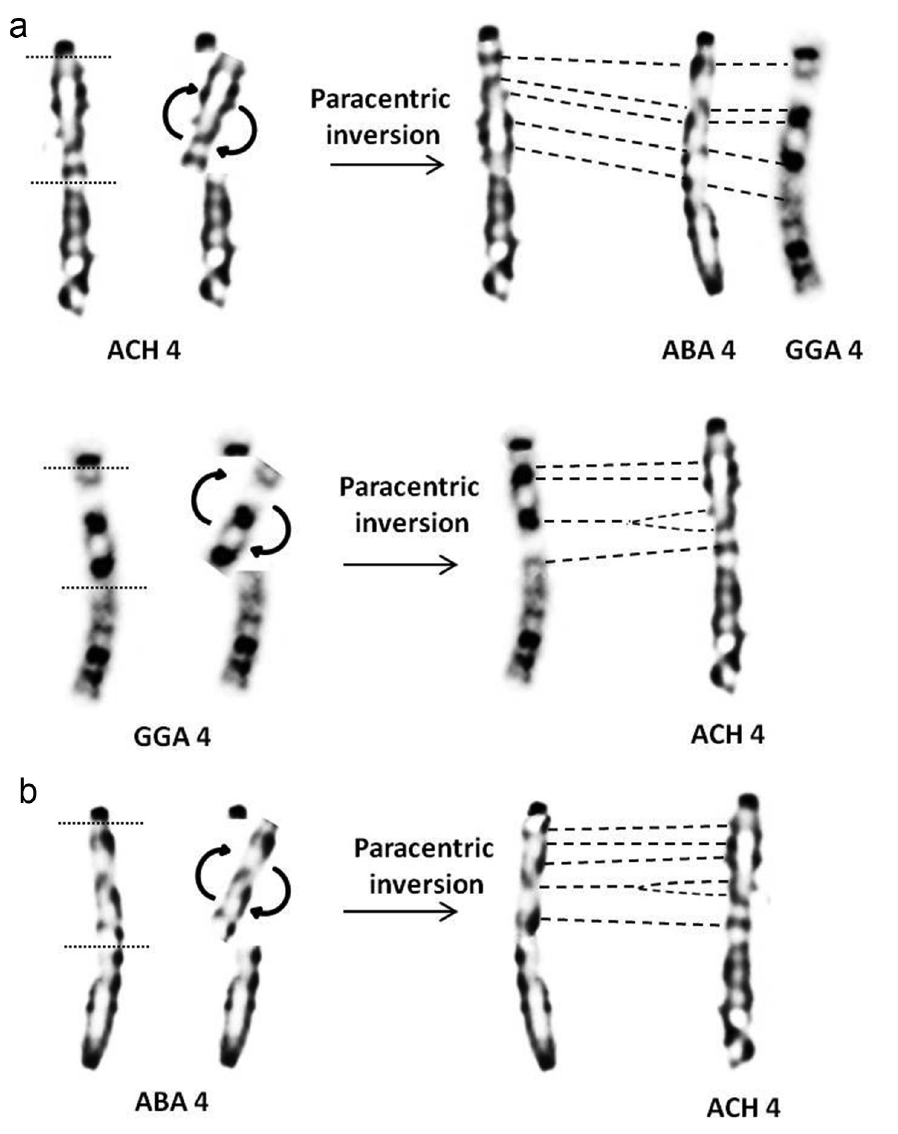
Figure 6. Schematic representation of a paracentric inversion in A. chukar ( a ), G.domesticus and A. barbara ( b ) chromosome 4. Corresponding bands are indicated by dashes. (ACH: A. chukar , GGA: G.domesticus and ABA: A. barbara